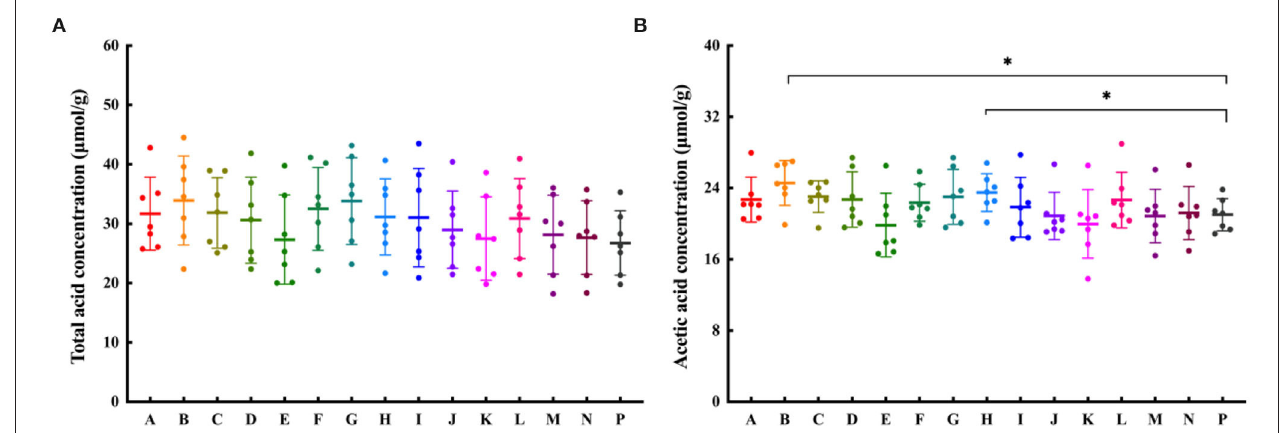
FIGURE 4 | The effect of CPFEs on SCFA production after 24-h in vitro fermentation. (A) Total SCFA concentration; (B) The acetic acid concentration; Data are shown as the mean ± SD ( n = 7). Significant differences among groups based on T -test, * P < 0.05. A, satsuma orange; B, chachiensis; C, ponkan; D, lane late navel orange; E, blood orange; F, apple pomelo; G, majia pomelo; H, grapefruit; I, dekopon; J, fertile orange; K, lemon; L, sichuan kumquat; M, longyan kumquat; N, bergamot; P, blank control.